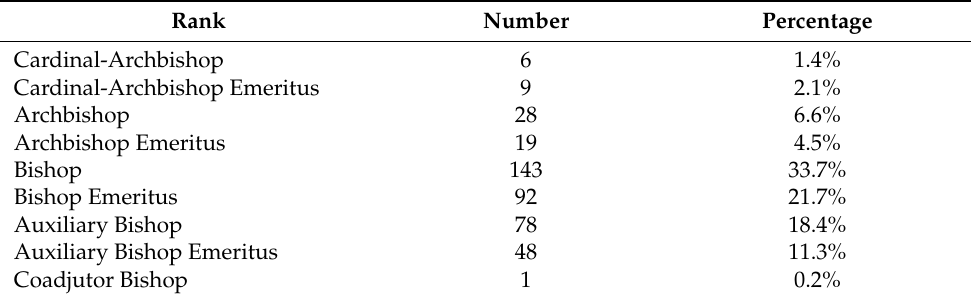
Table 1. Table 1. Ranks of bishop within USCCB sample, active and retired (July 2018).